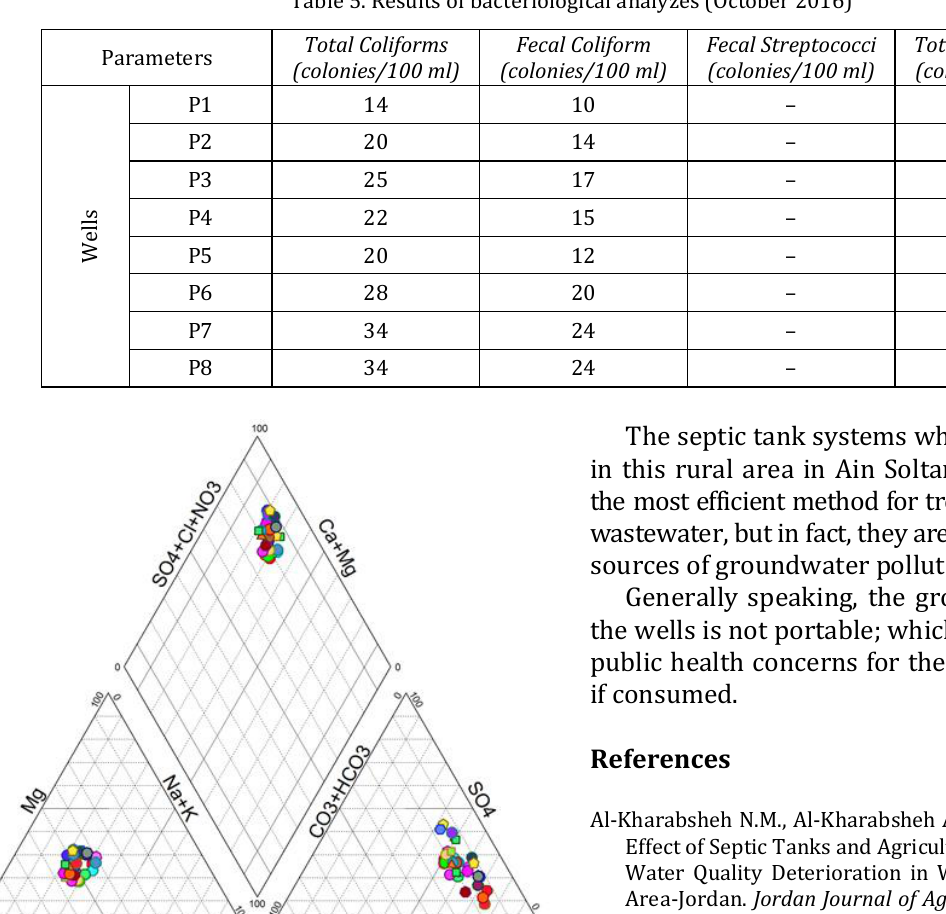
Table 5. Results of bacteriological analyzes (October 2016)